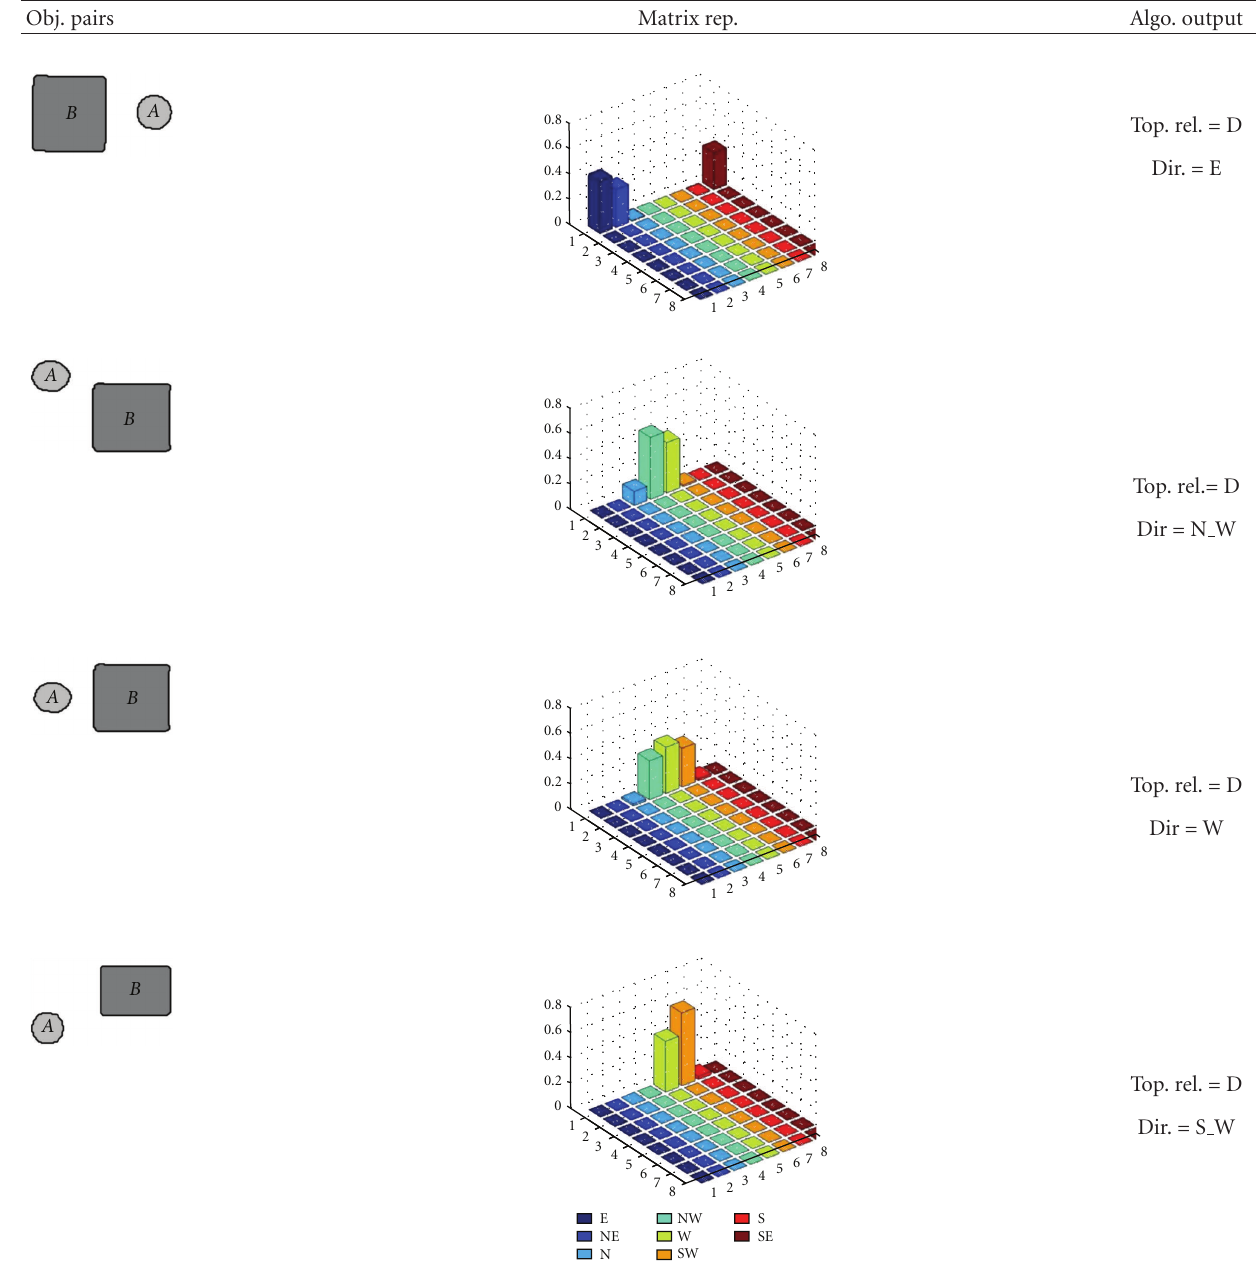
Table 2: Topological relation